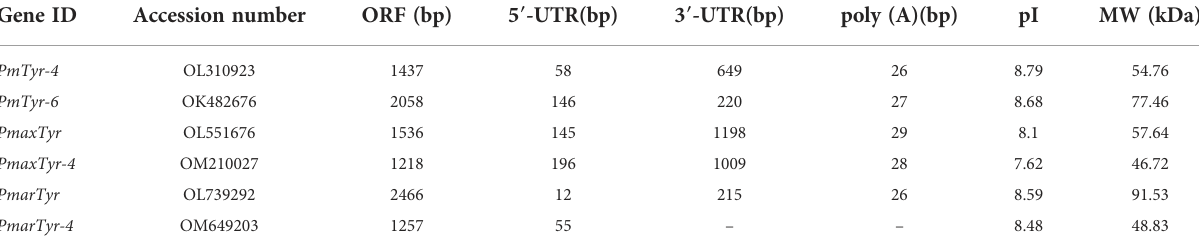
TABLE 1 The six cloned tyrosinase